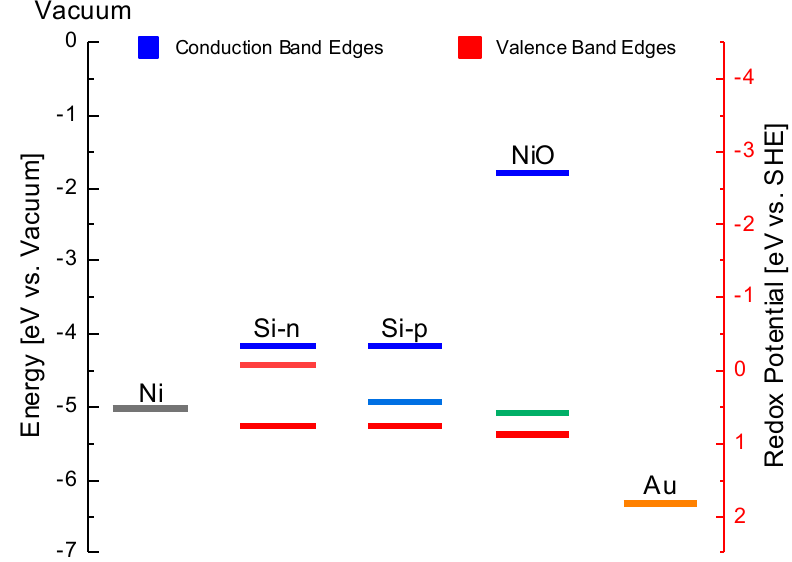
Figure 8. Diagram of electron energy levels on Ni, Si- n , Si- p and NiO band edges (Fermi level, conduction and valence bands) and the Au +/ Au redox system in solution [40,41,45].